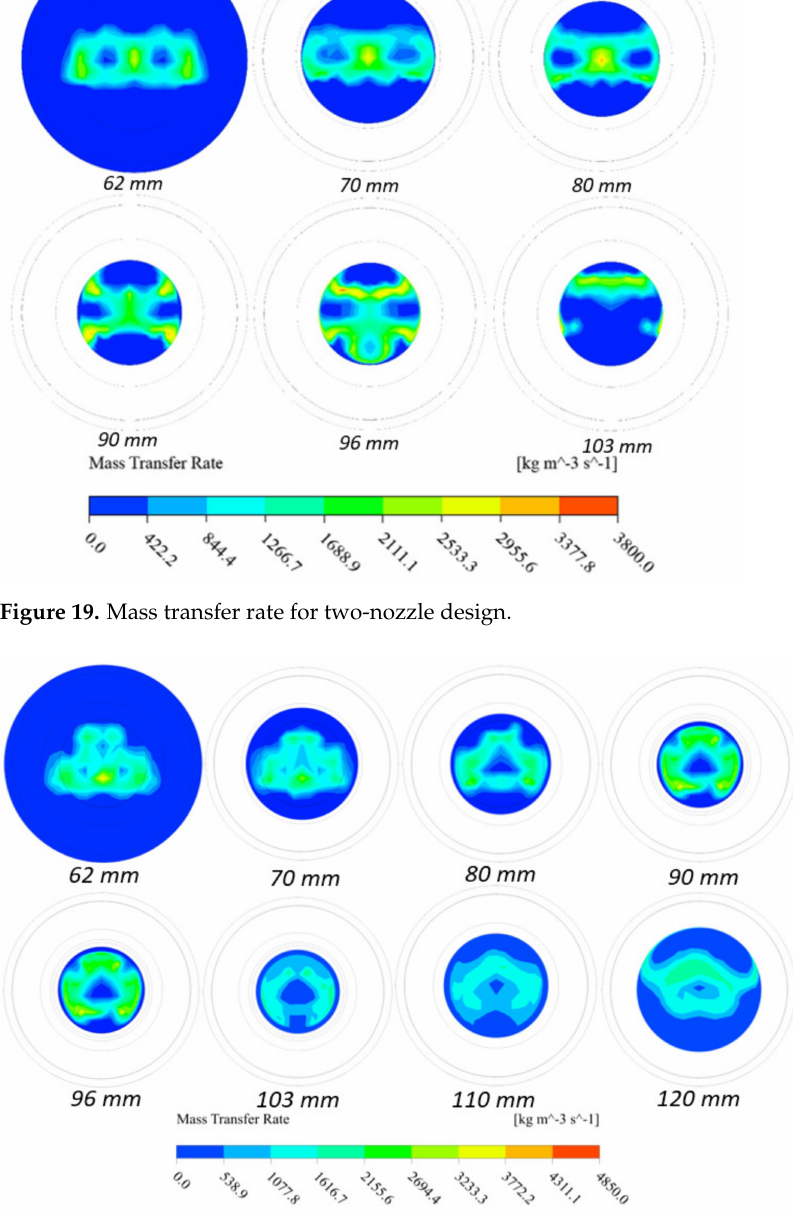
Figure 20. Mass transfer rate for three-nozzle